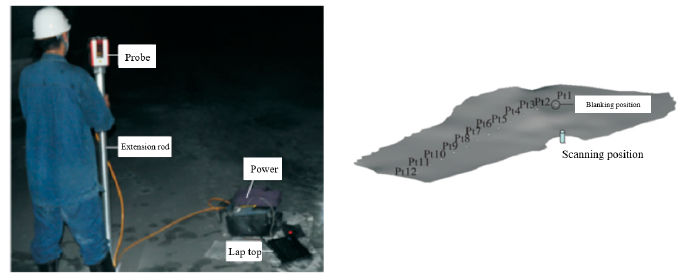
Figure 4. Flow path and slope monitoring of filling slurry in stope.